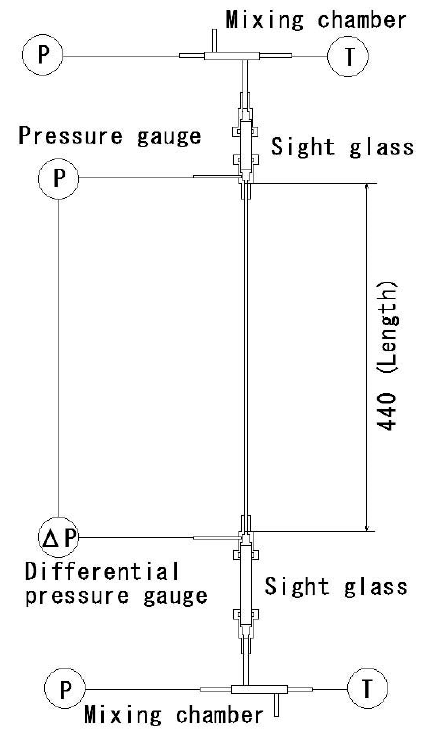
Figure 2. Test section for upward